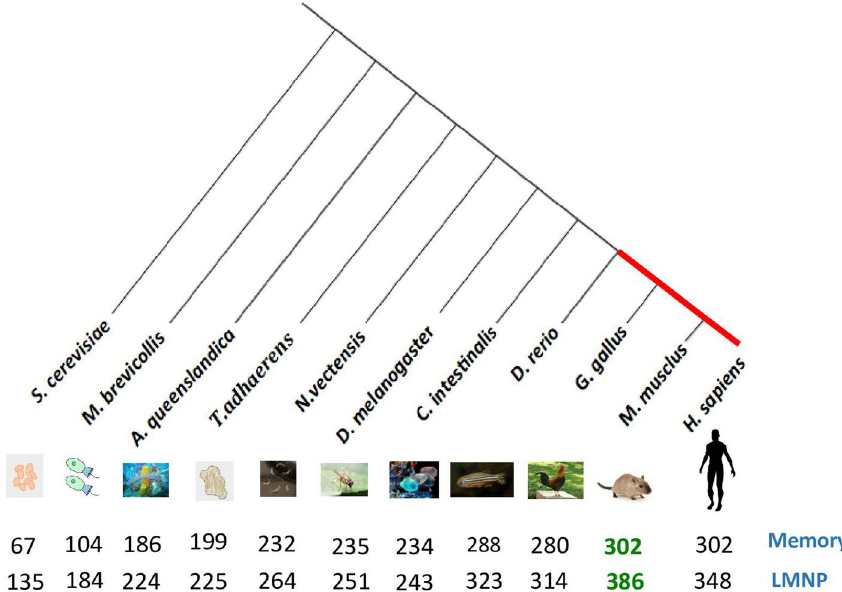
Figure 1. Orthologous detection of mouse memory-related genes and LMNP-related genes. The green color indicates the number of memory and LMNP-related genes in M. musculus , and the black color shows the orthologs of those genes. The red line represents species of